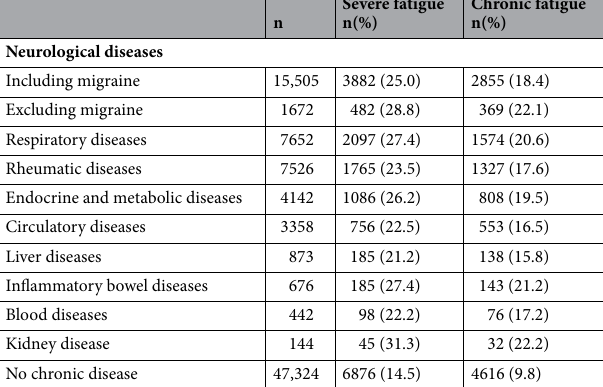
Table 2. Prevalence of severe and chronic fatigue in classes of chronic medical conditions and no chronic disease. *The classes of chronic medical conditions represent participants with multi-morbidity, hence subjects can be presented multiple times in the analyses.